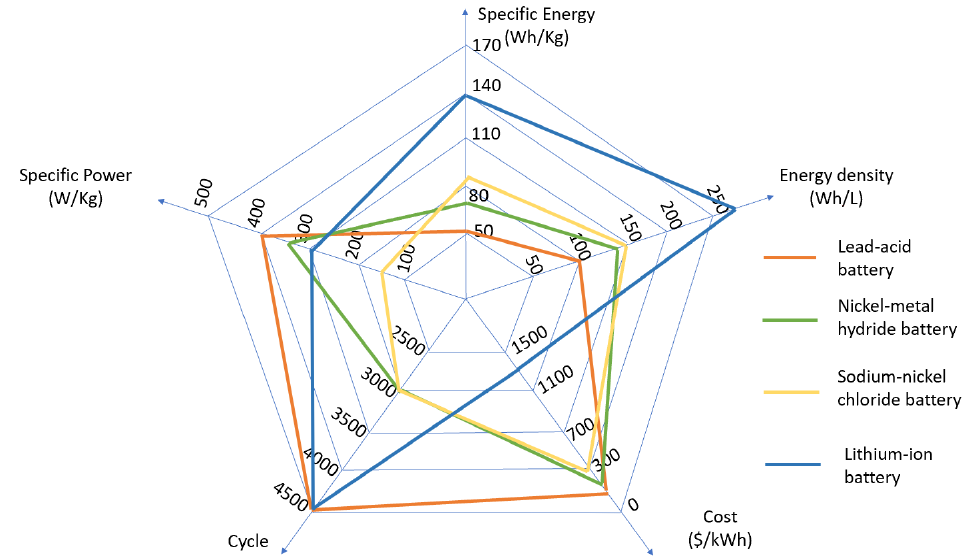
Figure 4. Comparison of the characteristics of various power batteries.